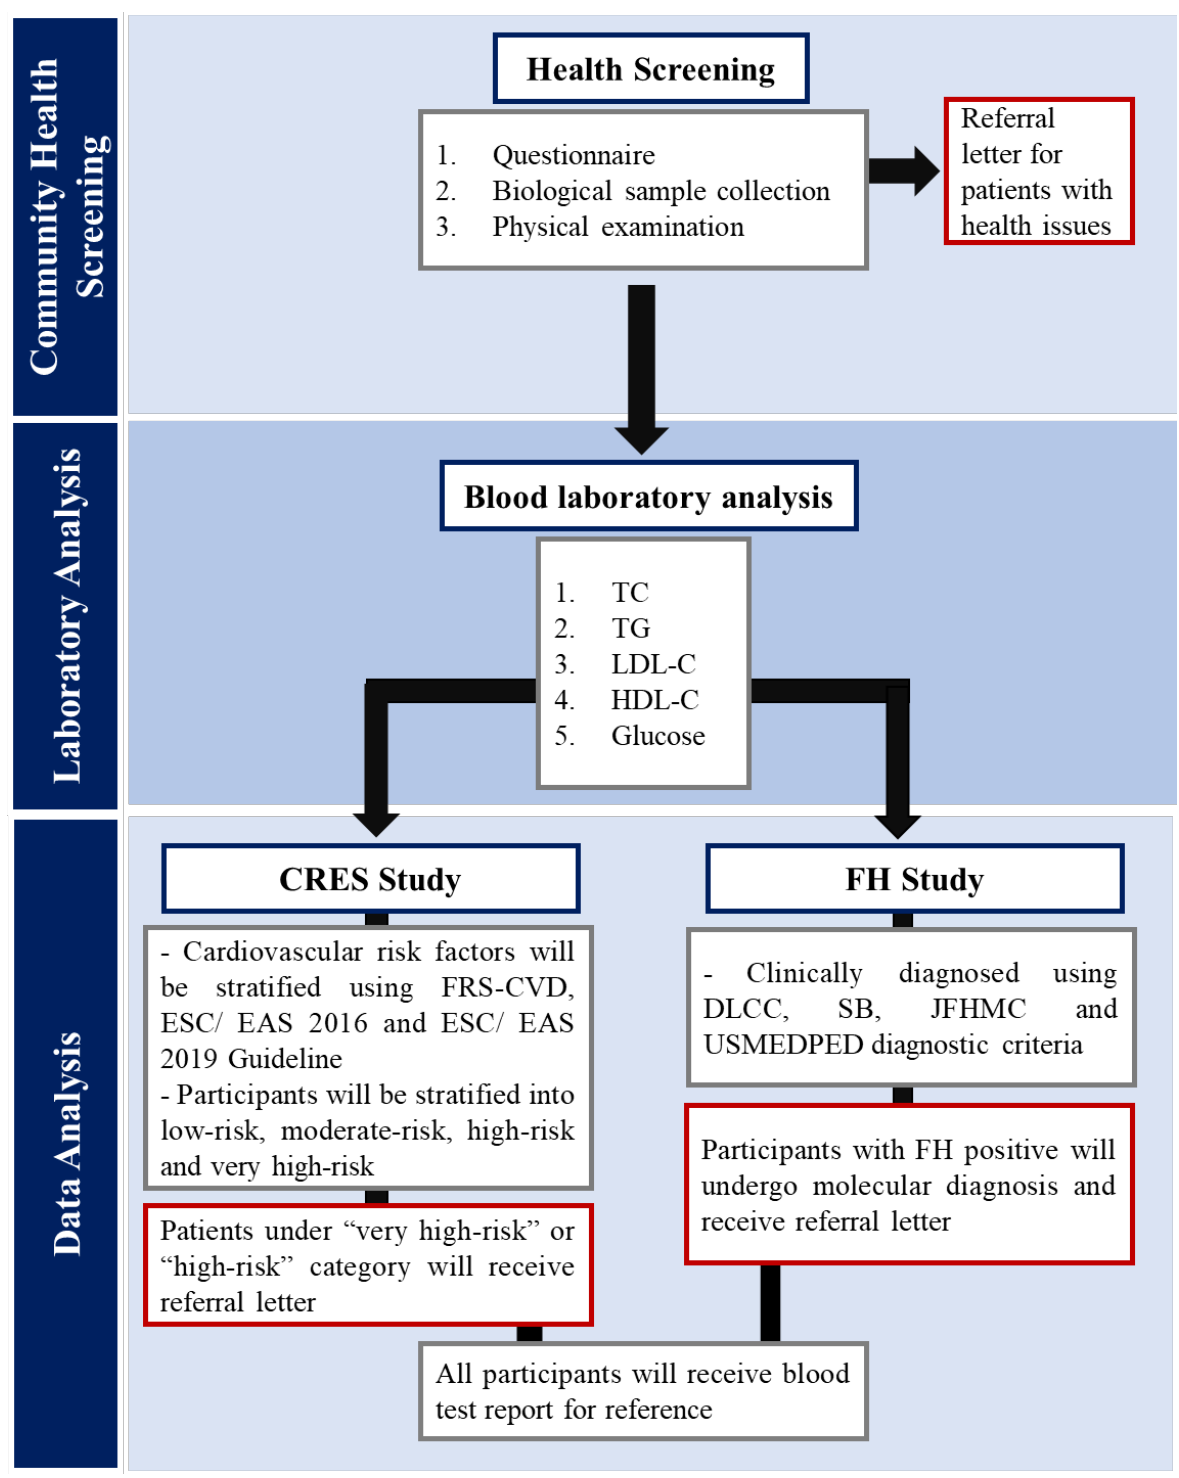
Figure 2. Overview of MyHEBAT study flow chart.